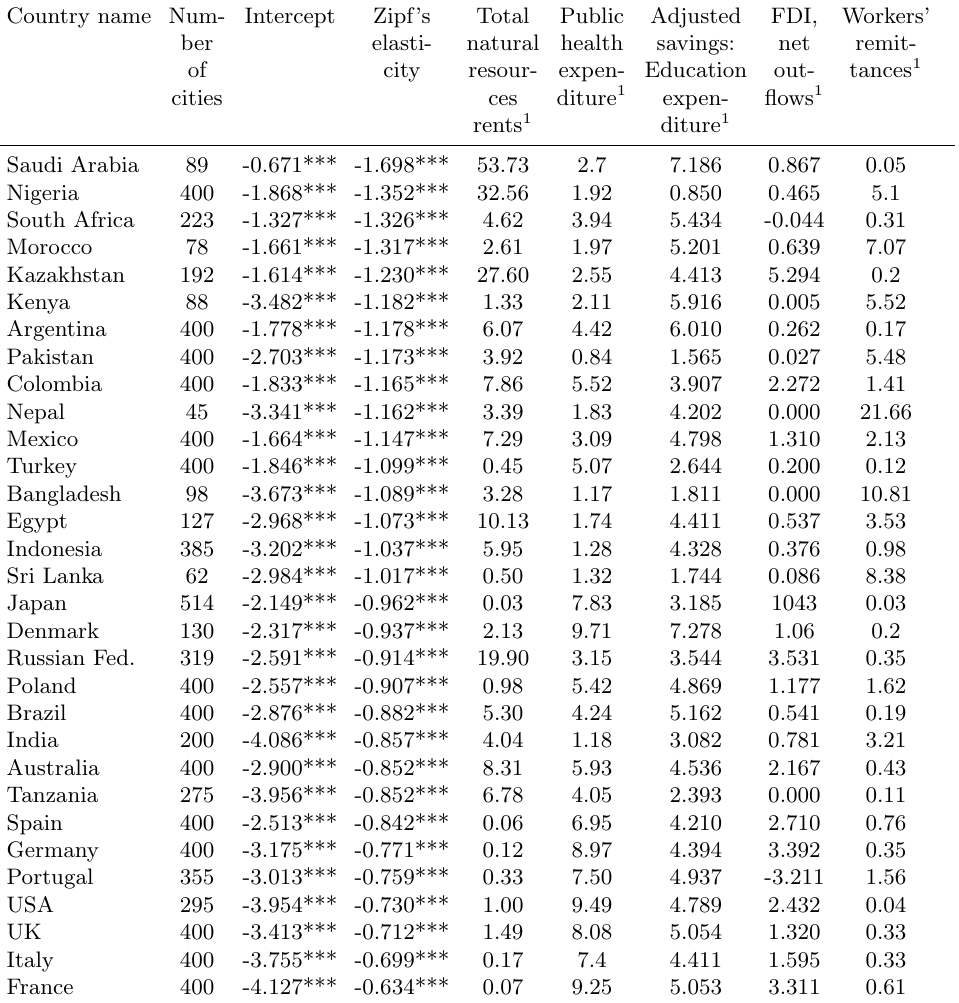
Table 1: Estimated Zipf curves coefficients and data on unilateral transferences (World Bank